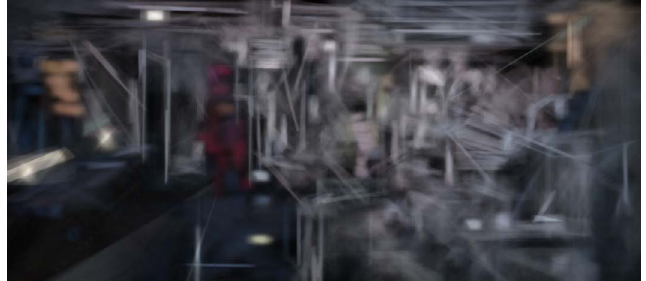
Figure 6: Ben Bogart, Watching (2001: A Space Odyssey) , 2019.